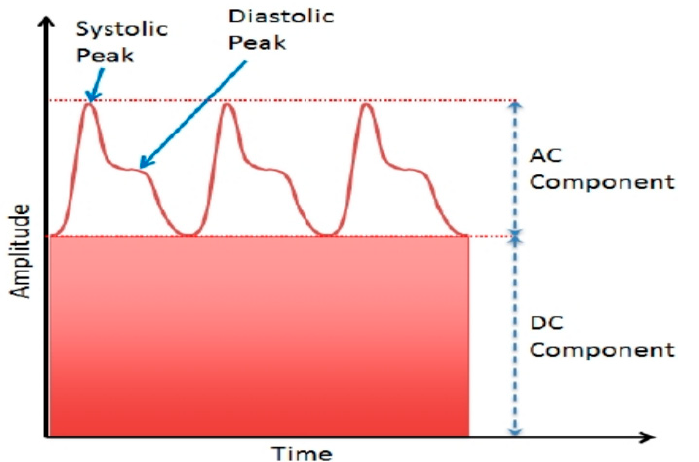
Figure 3. PPG signal comprising of AC and DC components [53] (Reprinted with permission from ref (53) Javier Pérez Contonente).